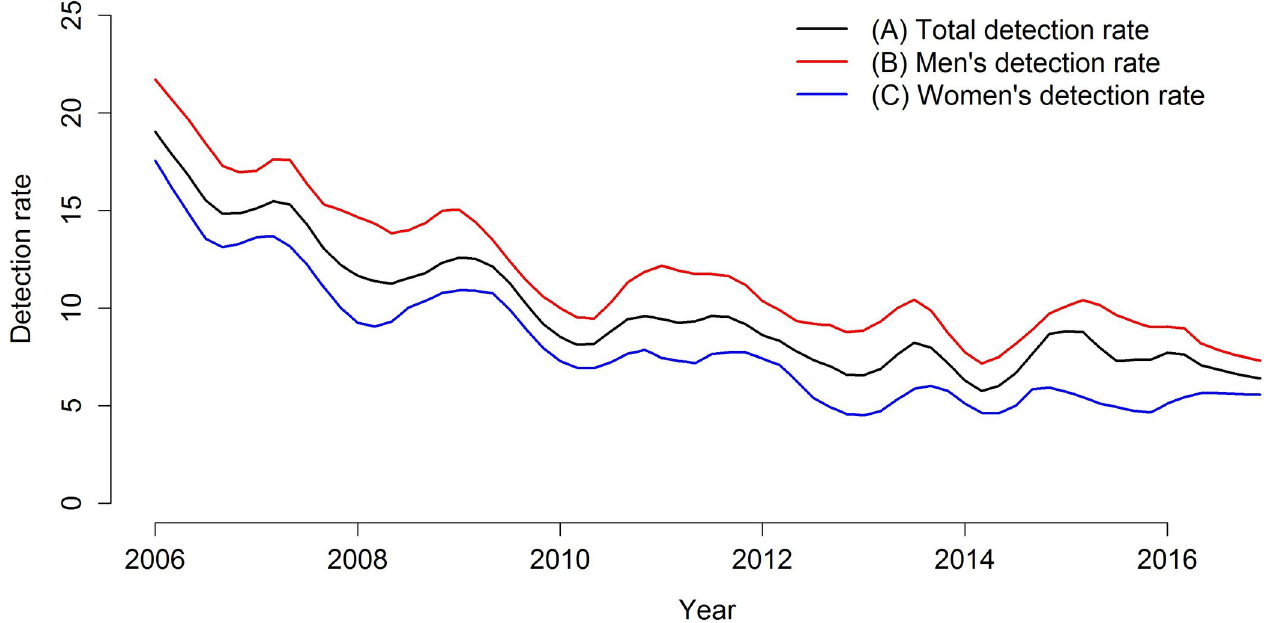
Fig 2. Trend of leprosy total detection rates and detection rates among men and women, Imperatriz, MA, Brazil (2006–2016). (A) Total detection rate; (B) Men’s detection rate; (C) Women’s detection rate. https://doi.org/10.1371/journal.pone.0237165.g002 The time series of the ratio between the detection rates of men and women is shown in Fig 3. The red line indicates the situation in which both rates would be equal (numerator equal to the denominator), and the blue line indicates the time period in that the ratio shows a change